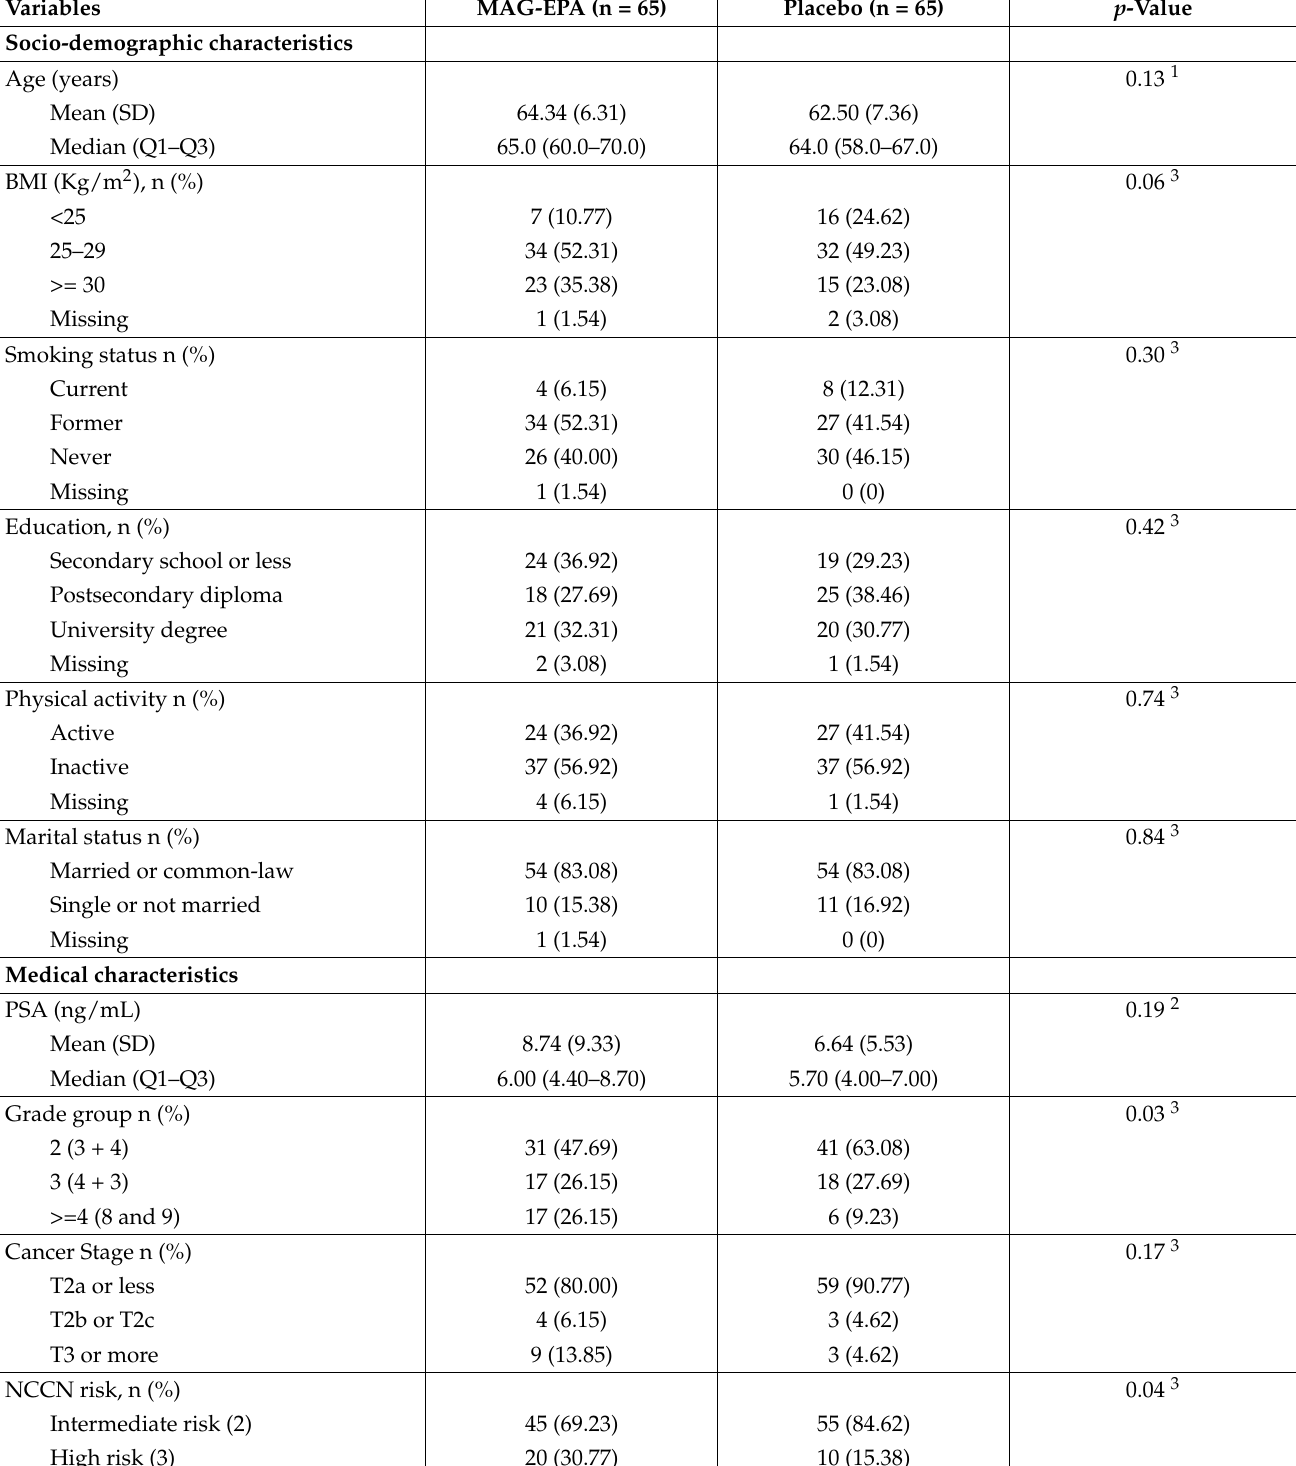
Table 1. Baseline characteristics of